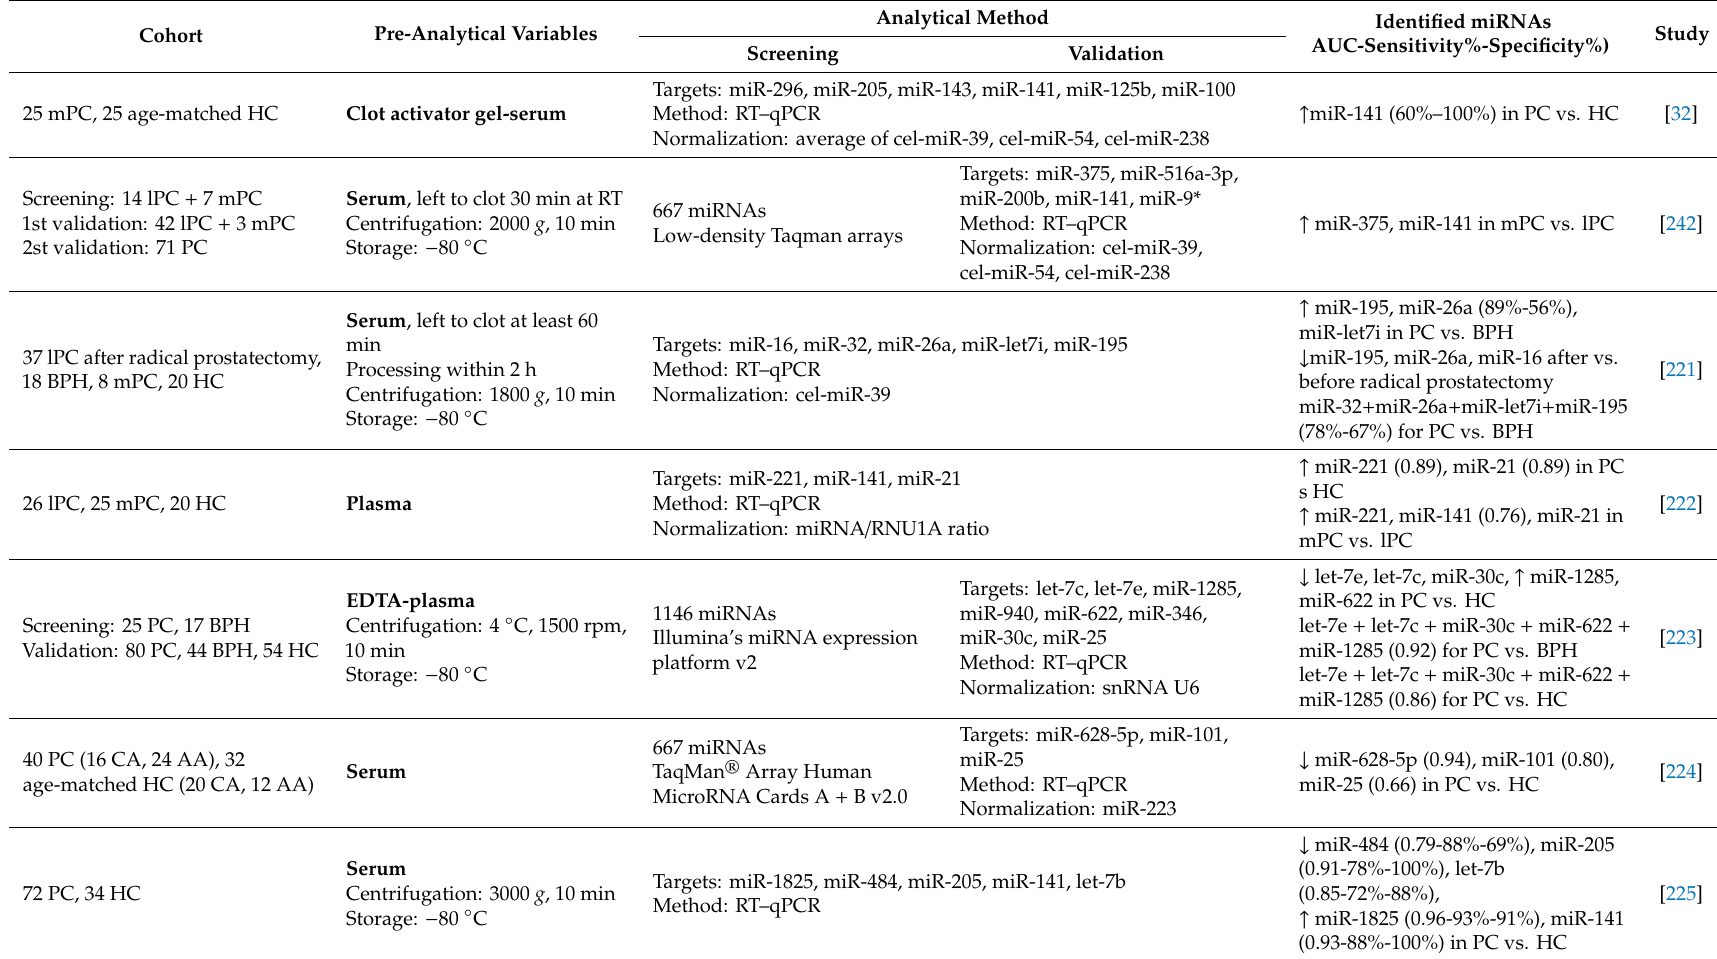
Table 3. Circulating miRNAs associated with prostate cancer